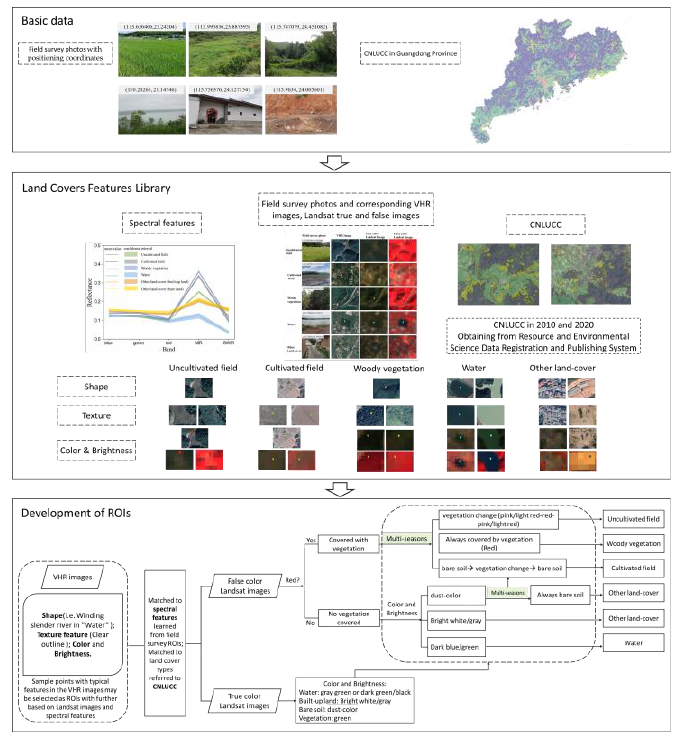
Figure 3. Developing basic, logic, and details of five land covers ROIs.